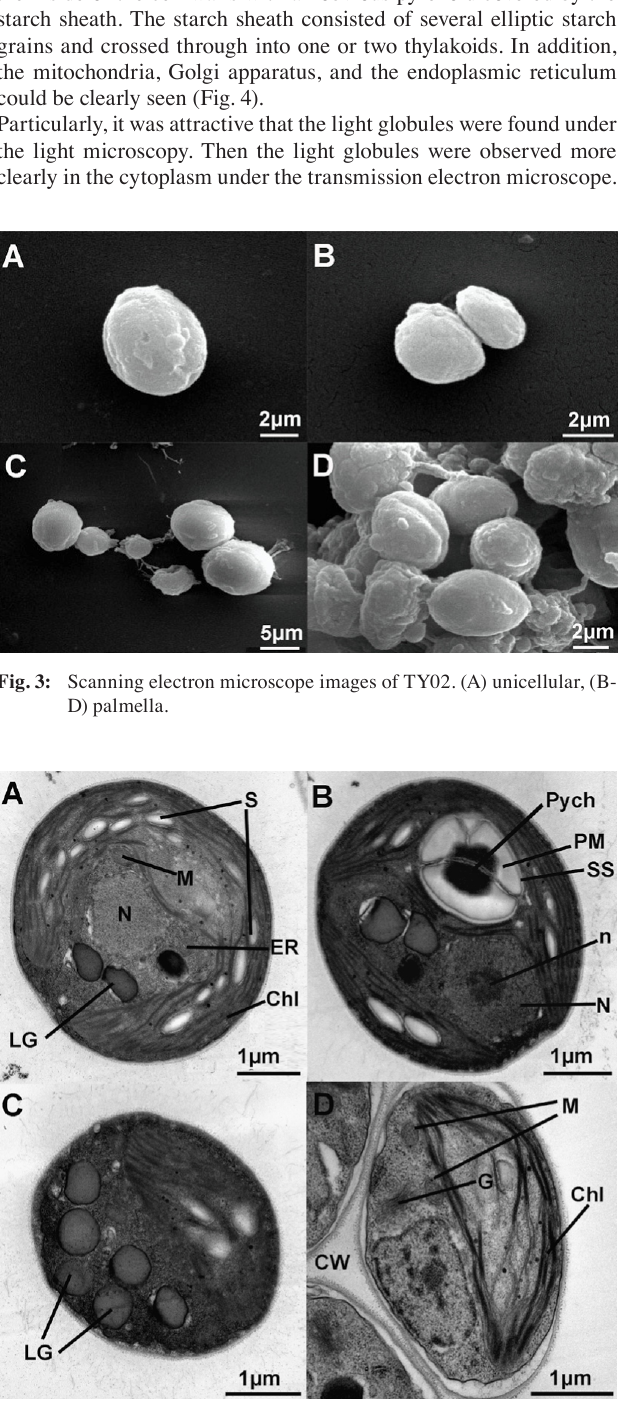
Fig. 4: Transmission electron microscope images of TY02. (S-starch grains, M-mitochondria, N-nucleus, ER-endoplasmic reticula, Chl- chloroplast lamellae, LG-lipid globules, Py-pyrenoid, SS-starch sheath, n-nucleolus, CW-cell wall, G-Golgi apparatus).